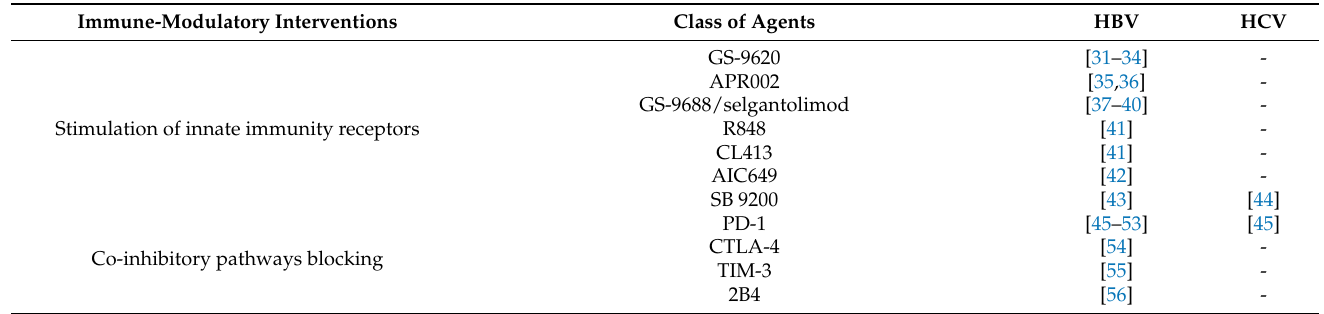
Figure 2. Immune based approaches in viral hepatitis. Many drugs that modulate the immune system have been employed in chronic HBV and HCV infections in order to reconstitute antiviral T cell responses and achieve viral clearance. ( A ) In vitro T cell modulatory treatments tested on patient-derived PBMCs and ( B ) on liver-derived lymphocytes to restore signaling deregulations, cytokine levels, metabolic functions and epigenetic landscape and to block inhibitory receptor signals. ( C ) In vivo T cell function reconstitution interventions are summarized. They target the activation of innate immunity receptors, such as toll like receptors (TLRs) and retinoic acid-inducible gene 1 (RIG-I) by specific agonists and through checkpoint blockade, such as with an anti-PD-1 monoclonal antibody (Nivolumab). p53, tumor-suppressor protein; p38, mitogen-activated protein kinase; ATM, Ataxia Telangiectasia Mutated; AMPK, AMP-activated protein kinase; MitoQ, mitoquinone; MitoTempo, mitochondria-targeted superoxide dismutase; PD-1, programmed cell death 1; 2B4, Natural Killer Cell Receptor 2B4; CTLA4, cytotoxic T lymphocyte antigen 4; TIM3, T cell immunoglobulin mucin receptor 3; LAG3, lymphocyte activation gene 3 protein; HMTs, histone methyltransferases; HDACs, histone deacetylases; NAD, Nicotinamide adenine dinucleotide; NMN, nicotinamide mononucleotide; ACAT, Acetyl-CoA Acetyltransferase. Table 1. Novel immuno-therapeutic approaches for HBV and HCV chronic infections.